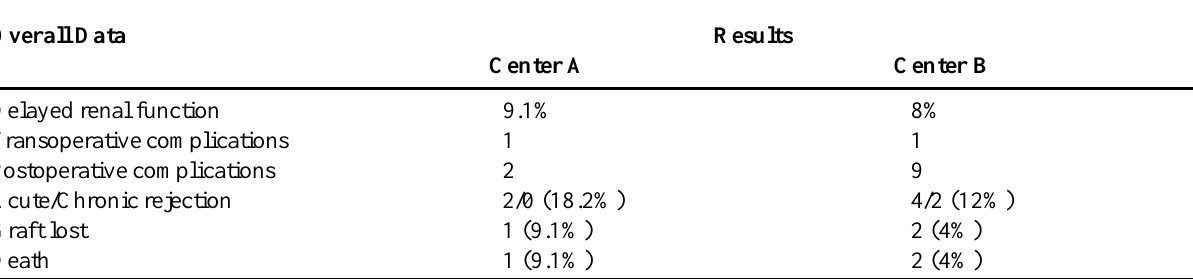
Table 3 – Overall data of recipients.